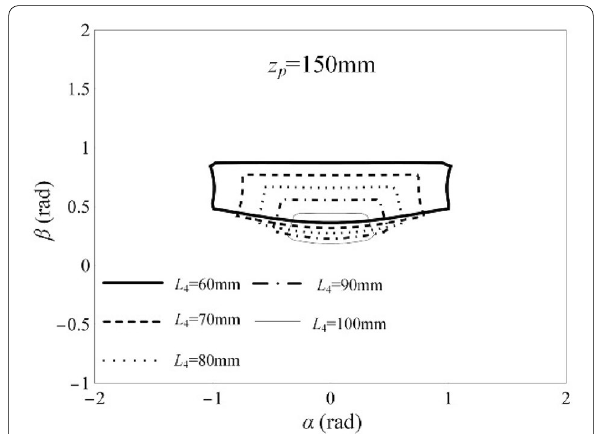
Figure 15 The image of the singular position of the mechanism when z p 150 mm =